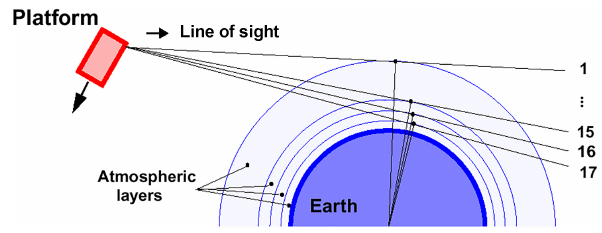
Figure 2. Observation geometry of MIPAS (Kleinert et al.,